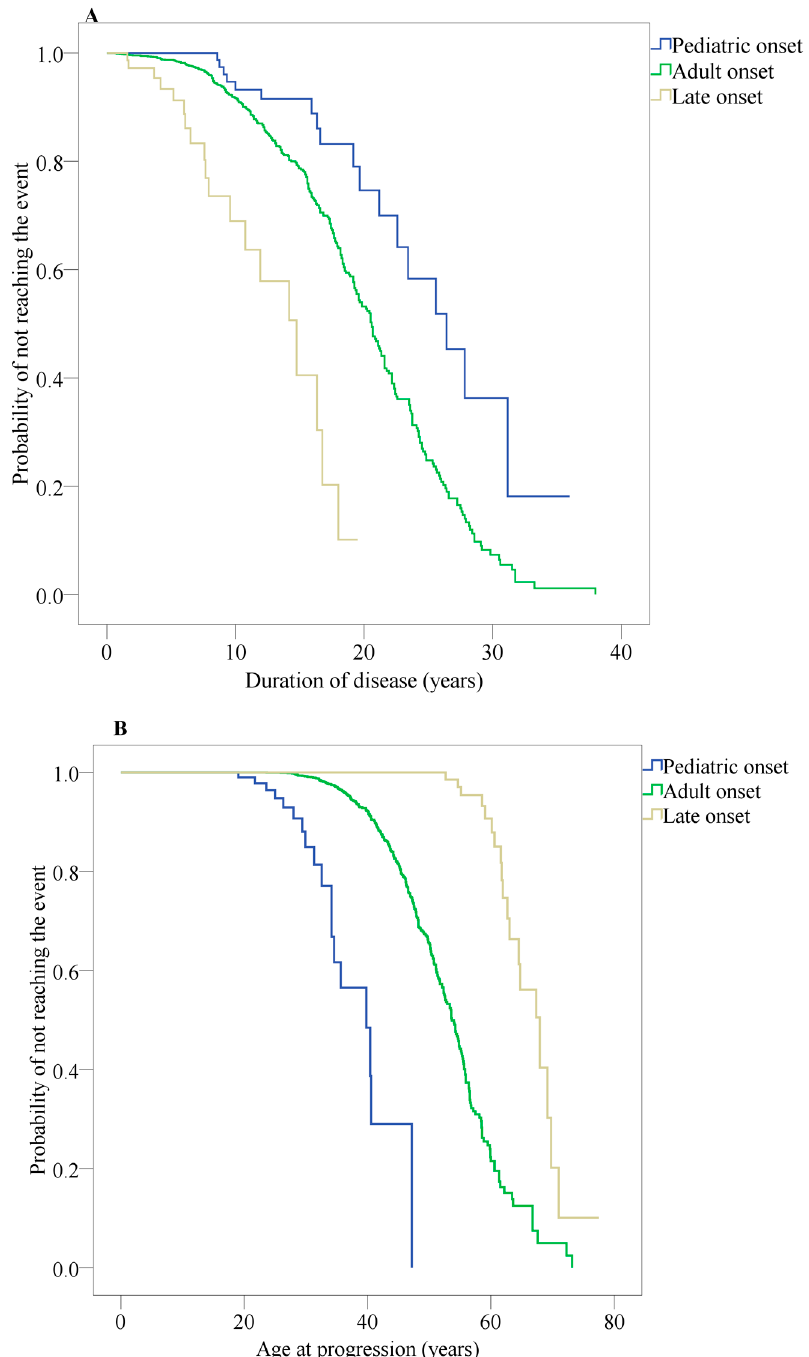
Figure 5. Kaplan–Meier survival curves of the probability estimates of not reaching secondary progression. ( A ) Time from disease onset to conversion from relapsing remitting MS (RRMS) to a secondary progressive MS (SPMS). ( B ) Time from birth to conversion from relapsing remitting MS (RRMS) to a secondary progressive MS (SPMS).